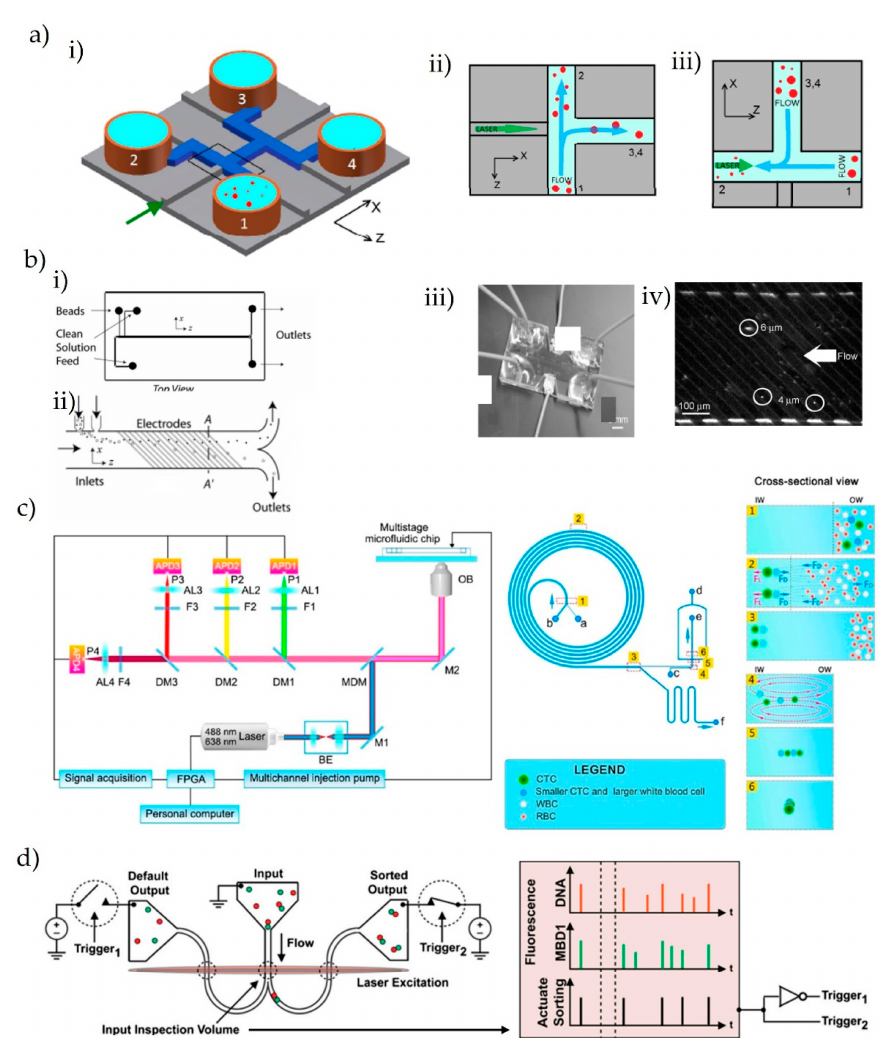
Figure 6. ( a ) ( i ) Layout of the ARROW optofluidic sorting device [283]. ( ii , iii ) Orientation of laser and flows [283]. ( b ) ( i ) Schematic of the sorting device with three inlets and two outlets [288] ( ii ) A cross-sectional view of the flow channel shows the locations of the planar electrodes and the beads during operation [288]. ( iii ) Photograph of the actual device [288]. ( iv ) Snapshot of 4- and 6- í m particles after separation at a distance of 30 mm from the inlet [288]. ( c ) Schematic Diagram of the Optical Path of the Four-Color Fluorescence Detection System and the Overall Composition of the OFCM. BE, Beam Expander Collimator; M1, M2, Reflectors; MDM, Multiband Dichroic Mirror; OB, Objective; DM1–DM3, Dichroic Mirrors; F1–F4, Filters; AL1–AL4, Lens; P1–P4, Pinholes; APD1– APD4, Avalanche Photodiodes; FPGA, Field-Programmable Gate Array [306]. ( d ) Single molecule detection and sorting